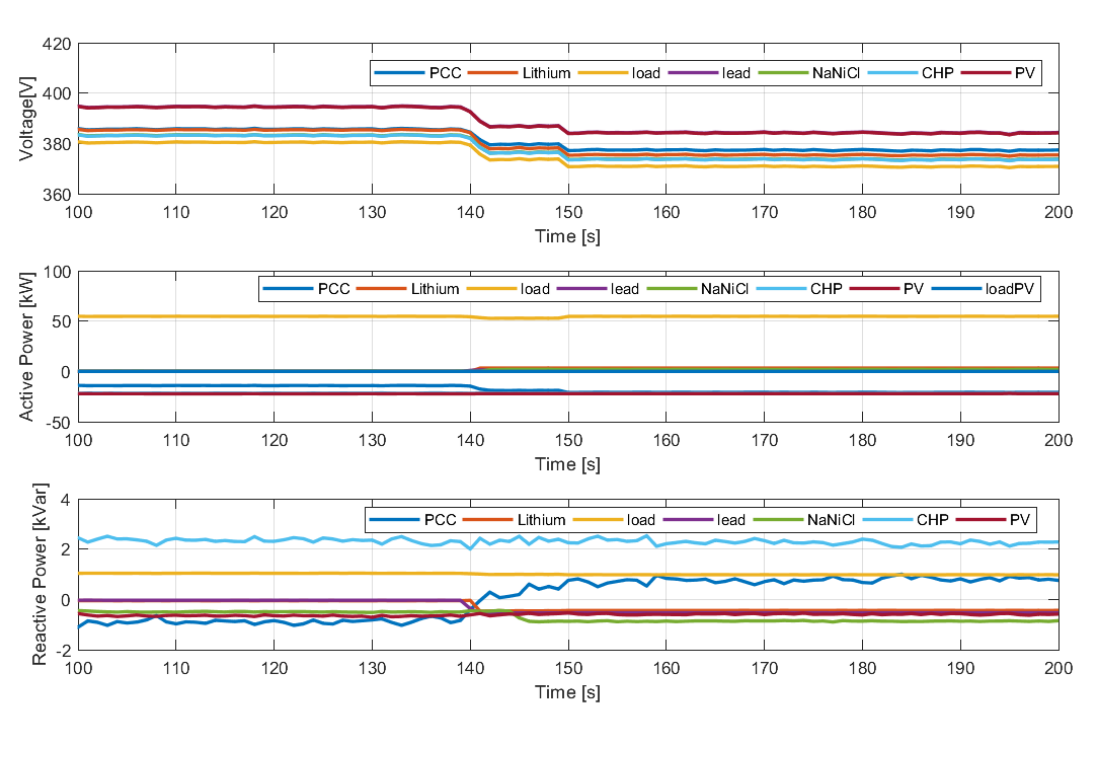
Figure 8. Voltage magnitudes in test system over time and active and reactive power outputs in overvoltage condition and with the active power control of all the resources in during islanded